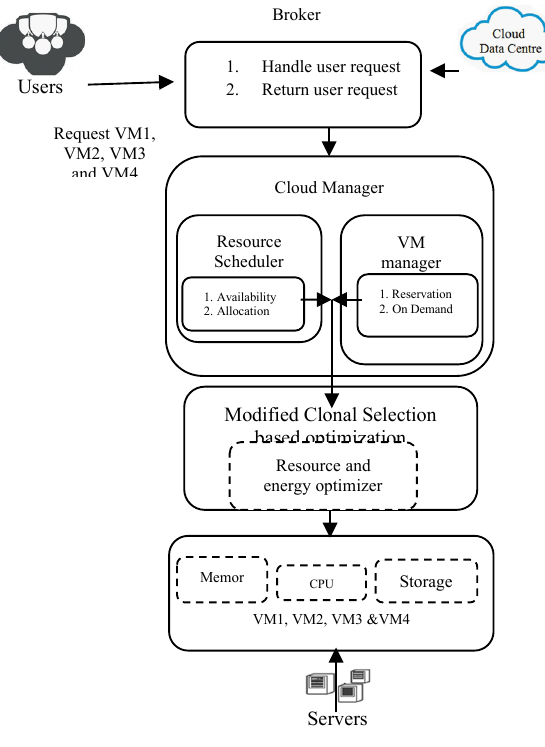
Figure 6. Energy-Efficient Model of Resource